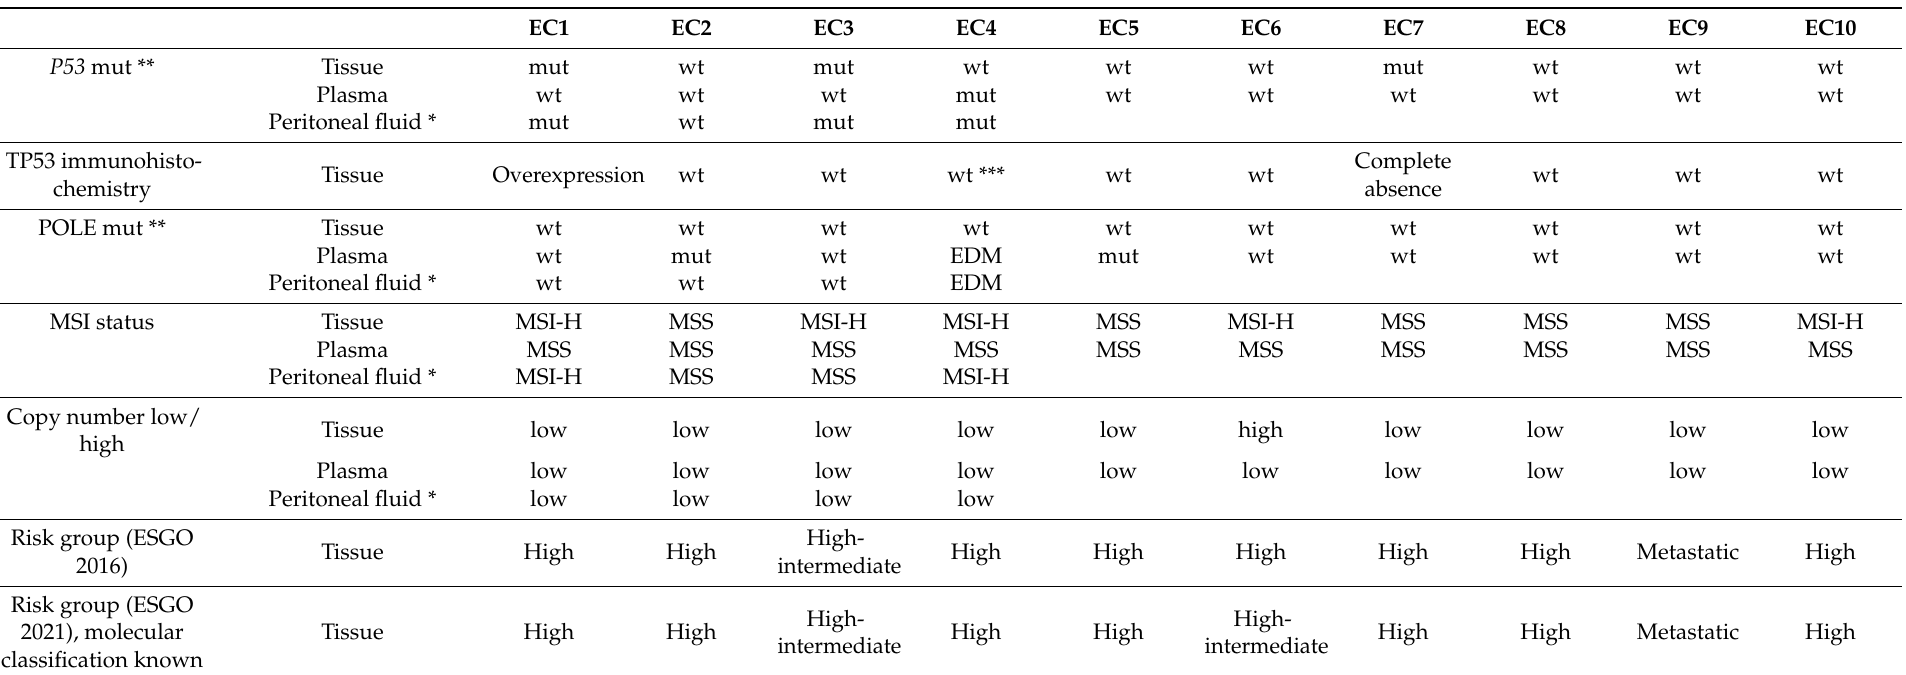
Table 2. Molecular classification of the 10 patients with endometrial